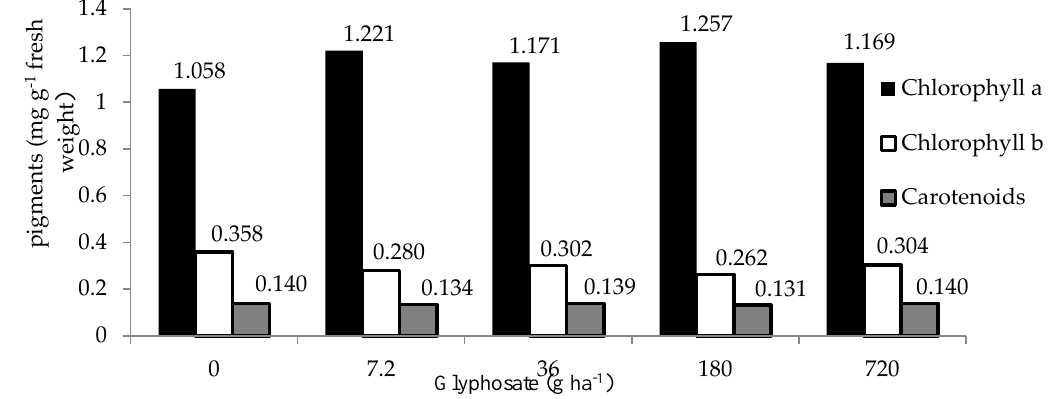
Figure 6. Effect of different glyphosate doses on photosynthetic pigments of A. retroflexus. Figure 6. E ff ect of di ff erent glyphosate doses on photosynthetic pigments of A. retroflexus